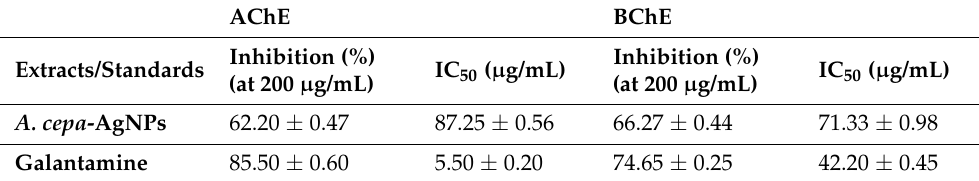
Table 3. The anticholinesterase activity of A. cepa